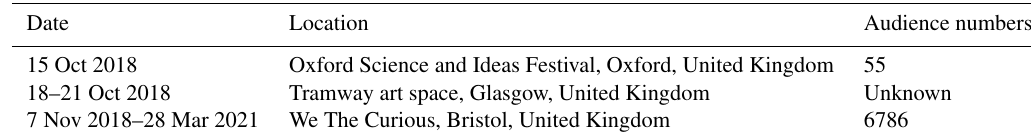
Table 2. Hertz tour locations and audience numbers.